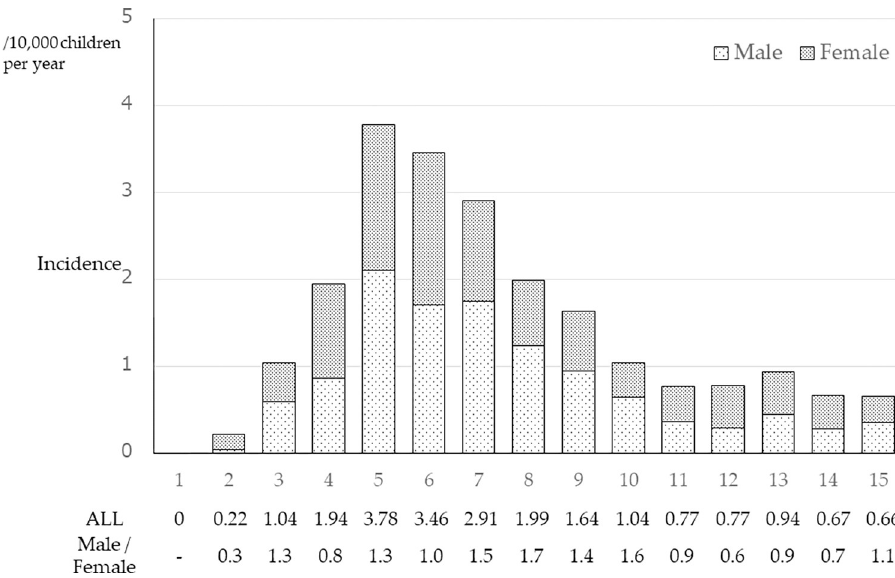
Fig 1. Estimated incidence of HSPN and male-to-female ratio. Estimated incidence of HSPN and male-to-female ratio in each age group of Japanese children aged 1 year to 15 years.